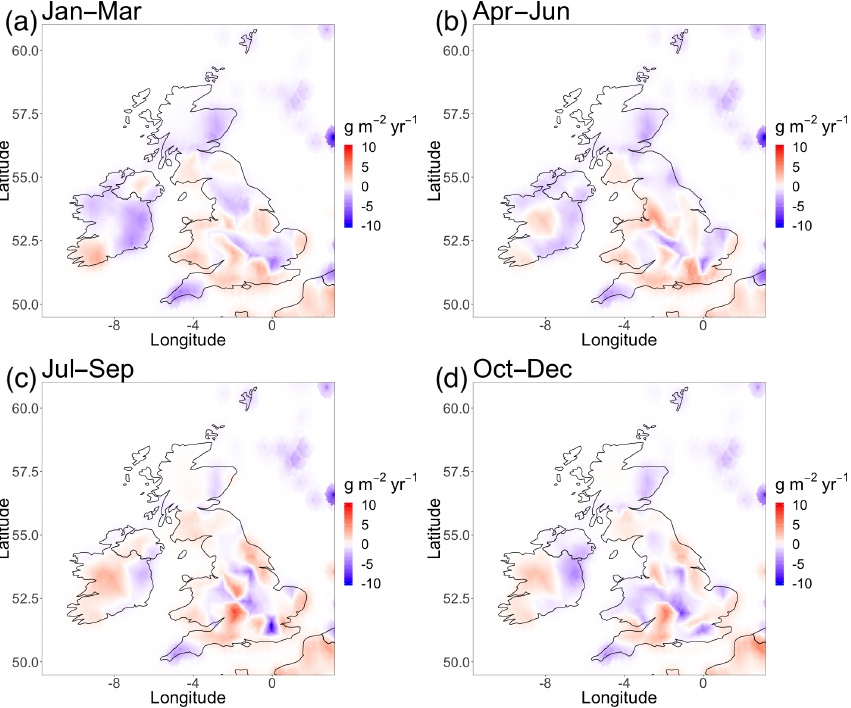
Figure 6. Inferred mean difference in methane emissions for the UK in 2014 compared to the EDGAR inventory for (a) January to March, (b) April to June, (c) July to September and (d) October to December.